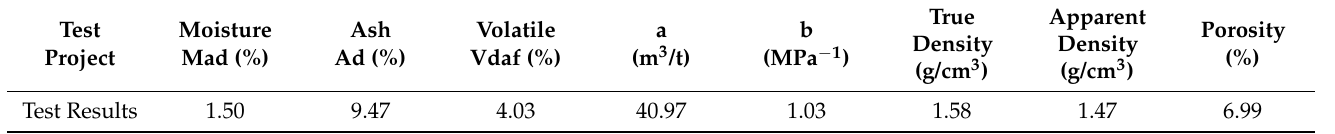
Table 1. Measurement results of basic parameters of coal samples.